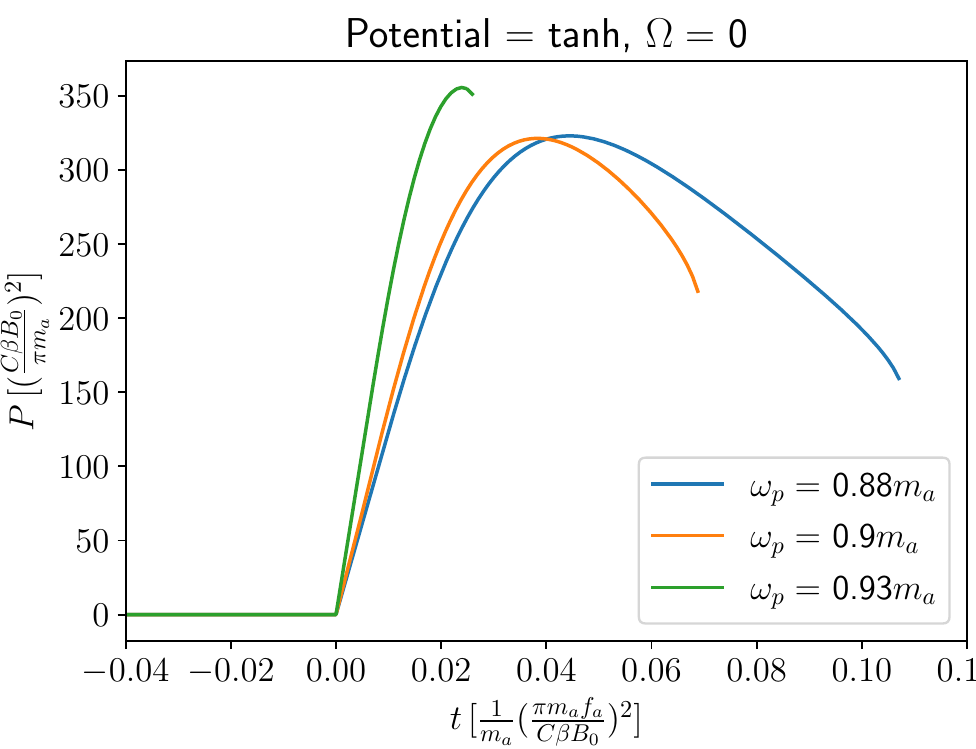
Figure 6 . The electromagnetic radiated power as a function of time in the case of an axion clump that is initiated with a clump frequency ω ( t 0 ) , less than the plasma frequency. Time t = 0 is defined as the time when k ω = 0 , while for t < 0 the clump only evolves through the emission of scalar waves. The rightmost point on each curve is the time at which ω = ω crit